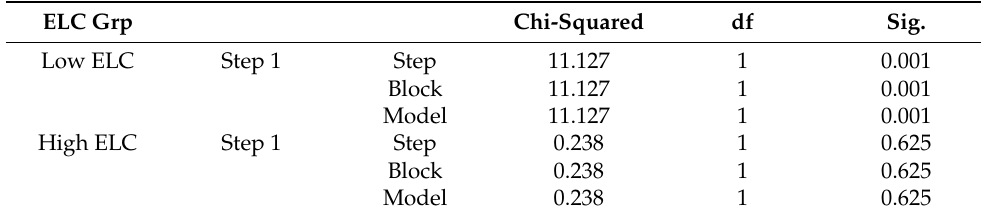
Table 3. Omnibus Test for the coefficients of the model. ELC Grp